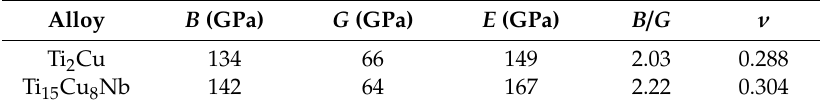
Table 3. B , G , E , and ν of the Ti 2 Cu intermetallic.